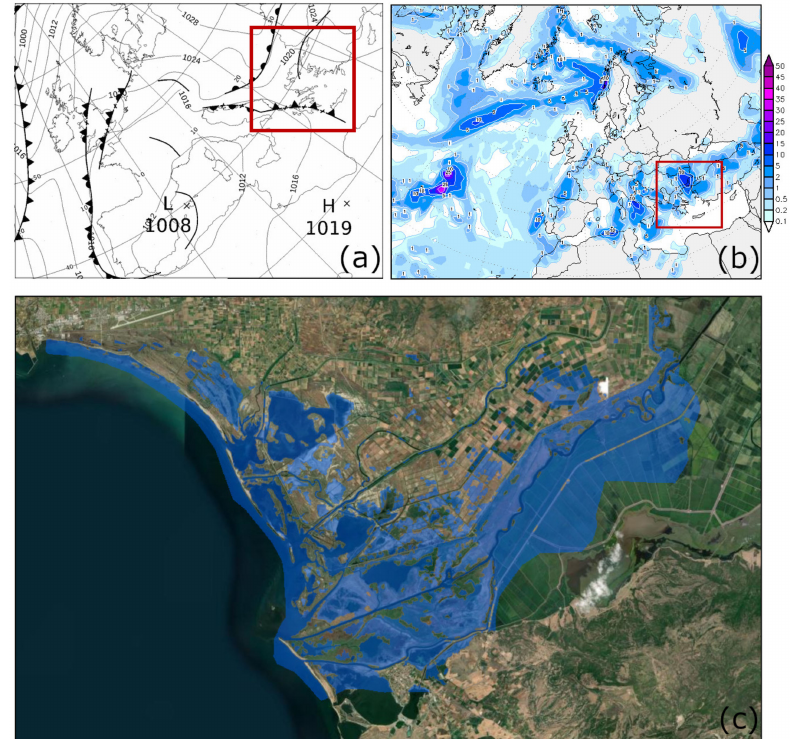
Figure A4. As in Figure A1, but for the 2014 flood event.